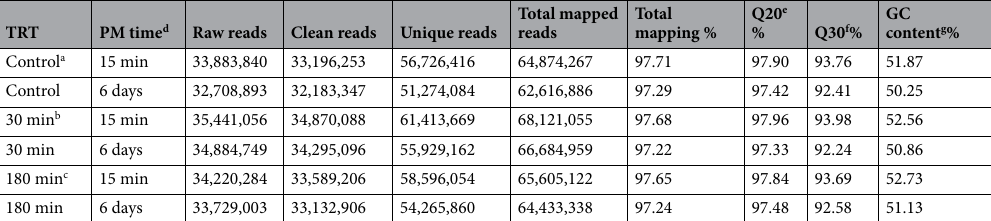
Table 2. Summary of sequencing results of Longissimus dorsi muscle samples from carcasses of goats subjected to transportation stress treatment (TRT). a Not transported but held in pens; b transported for 30 min; c transported for 180 min; d postmortem (PM) sample collection time (15 min or after 6 days of aging); e phred values greater than 20 base number contain the percentage of total bases; f phred values greater than 30 base number contain the percentage of total bases; g the percentage of guanine and cytosine base numbers of total